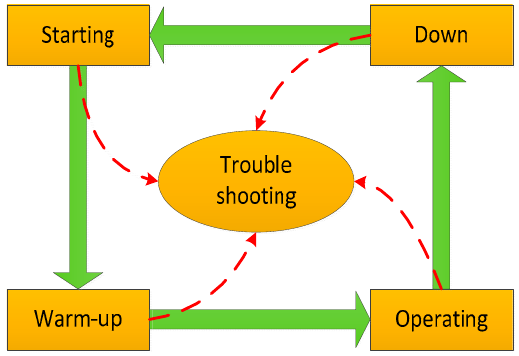
Figure 8. The control logic of the APU system.